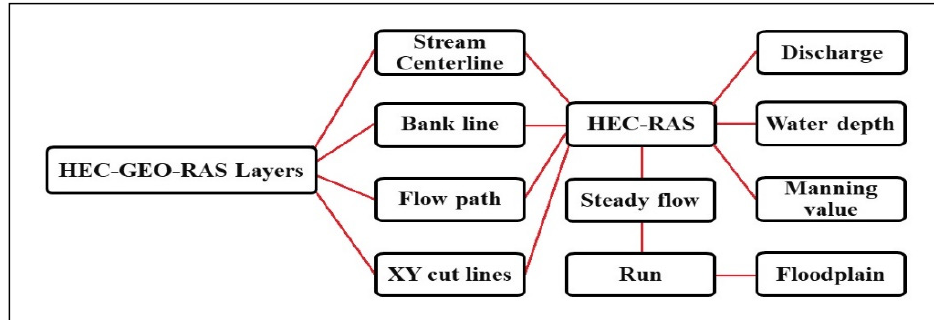
Figure 4. Flowchart for HEC-RAS methodology.